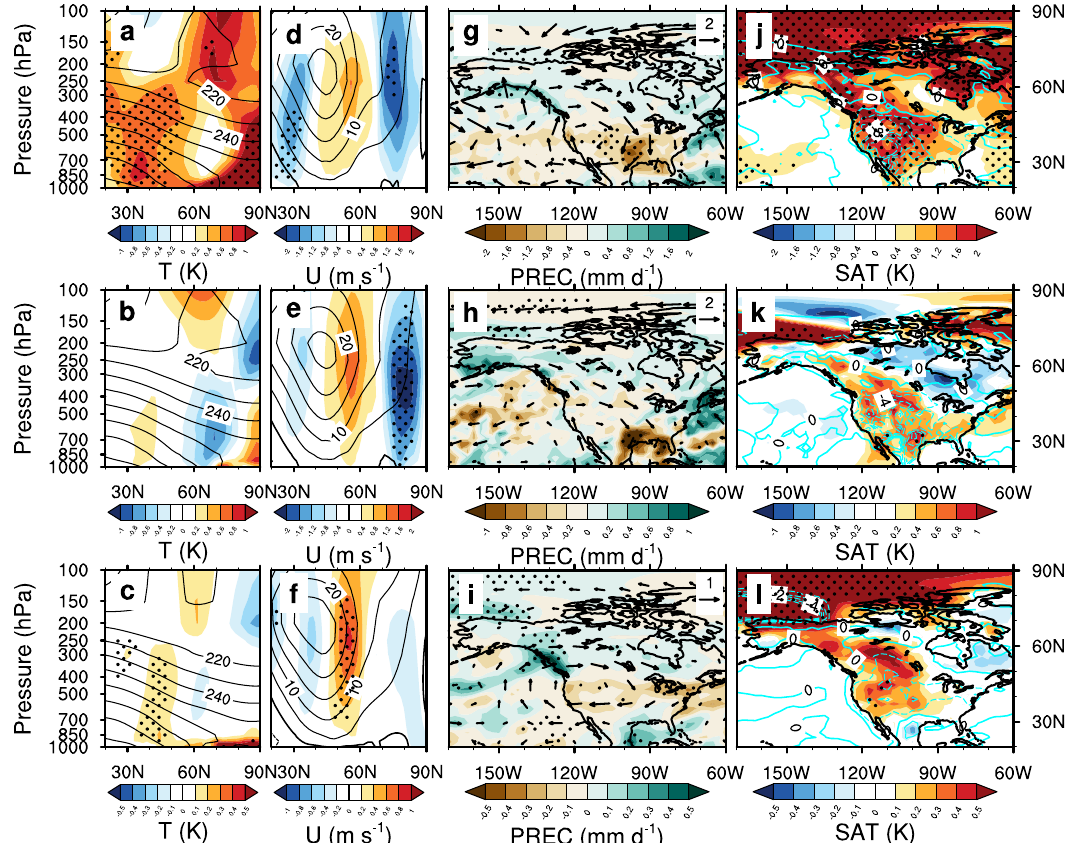
Fig. 3 Physical processes underlying the Arctic sea ice and regional fi re teleconnection. a Zonally averaged (170°W to 60°W; as shown in g ) temperature (T; color shading; unit: K) difference in autumn and early winter (September to December) between the years with minimum (SIC − ) and maximum sea-ice concentration (SIC + ) based on the original ERA5 reanalysis data. The time average of zonally averaged temperature in the SIC + years is also shown (contours; unit: K). b As in a , but for the temperature difference between the years with minimum (SICnotrd − ) and maximum sea-ice concentration (SICnotrd + ) based on the detrended ERA5 reanalysis data. c As in a , but for the temperature difference between the experiments with minimum (SICexp − ) and maximum sea-ice concentration (SICexp + ) based on the CESM-RESFire simulations. d – f As in a – c , but for zonally averaged zonal wind (U; color shading; unit: ms − 1 ) difference based on the original ERA5 reanalysis data, the detrended ERA5 reanalysis data, and the CESM-RESFire simulations, respectively. g – i As in a – c , but for wind circulation at 500hPa (arrows; unit: ms − 1 ) and total precipitation rate (PREC; color shading; unit: mmd − 1 ) differences based on the original ERA5 reanalysis data, the detrended ERA5 reanalysis data, and the CESM-RESFire simulations, respectively. j – l As in a – c , but for surface relative humidity (cyan contours with negative values in dashed lines; unit: %) and surface air temperature (SAT; color shading; unit: K) differences based on the original ERA5 reanalysis data, the detrended ERA5 reanalysis data, and the CESM-RESFire simulations, respectively. Stipples in a – l show regions that are signi fi cantly different from 0 at the 0.1 signi fi cance level of a two-sided t